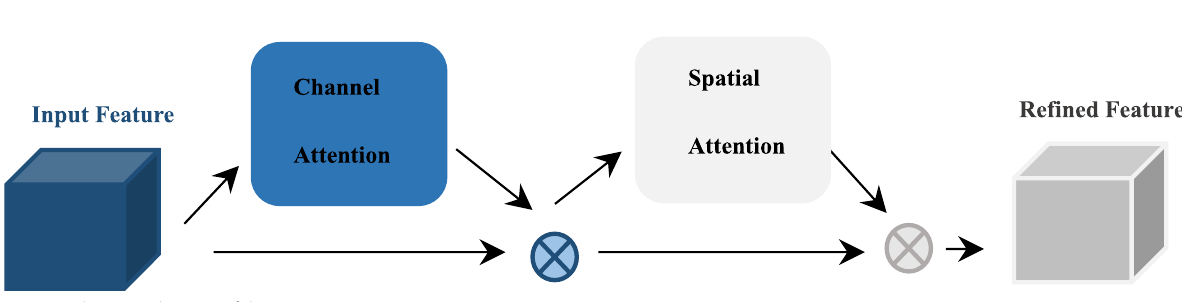
Fig. 2 Schematic diagram of the CBAM